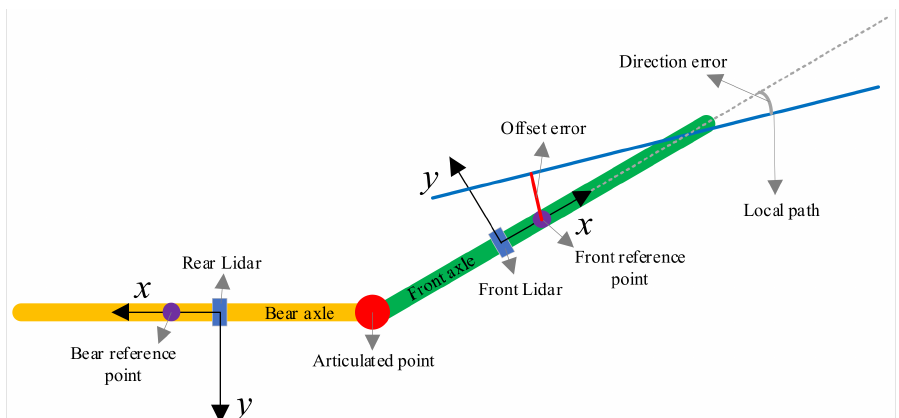
Figure 6. Schematic diagram of error